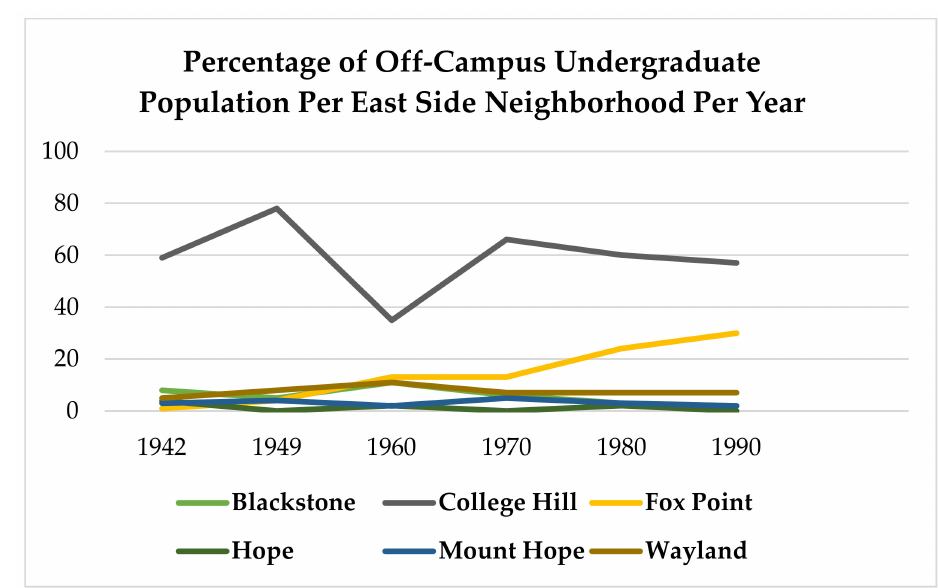
Figure 8. Percentage of Brown’s o ff -campus undergraduate population per East Side neighborhood per year. Note that because significant portions of the Brown graduate population lived outside the East Side, graduate students are not included in these tabulations. Source: Calculated by authors from student address books in the Brown Archives [83–87]. Table 1 indicates the shift in population the Fox Point community groups and university